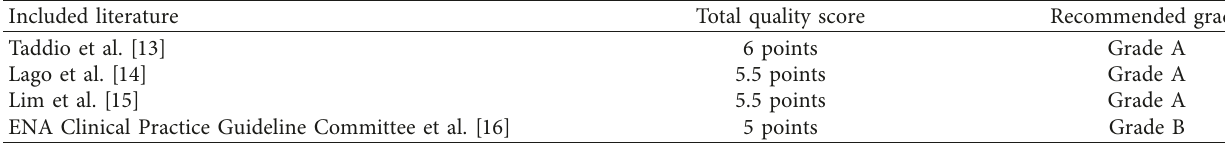
Table 2: Quality evaluation of the guideline.